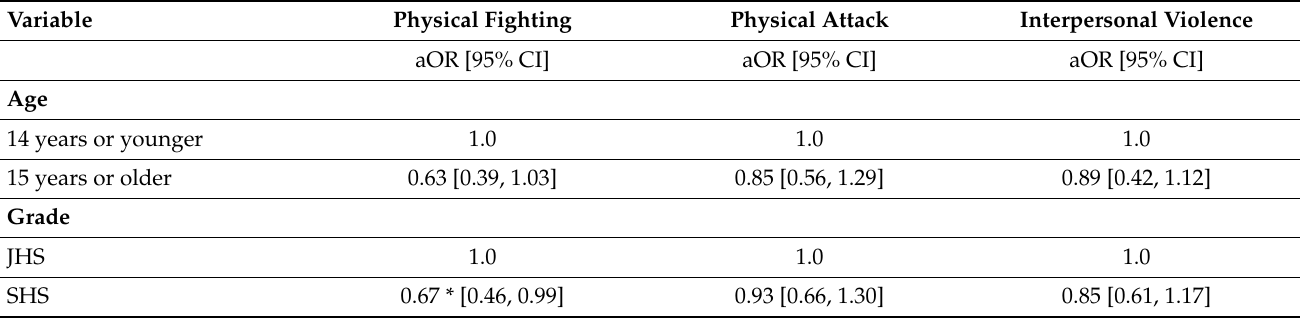
Table 2. Multivariable regression analysis of physical fighting, physically attacked, and interpersonal violence among in-school adolescents in